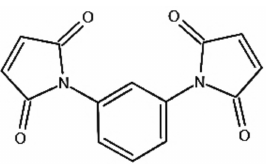
Figure 1. Molecular structure of N, N’-m-phenylene